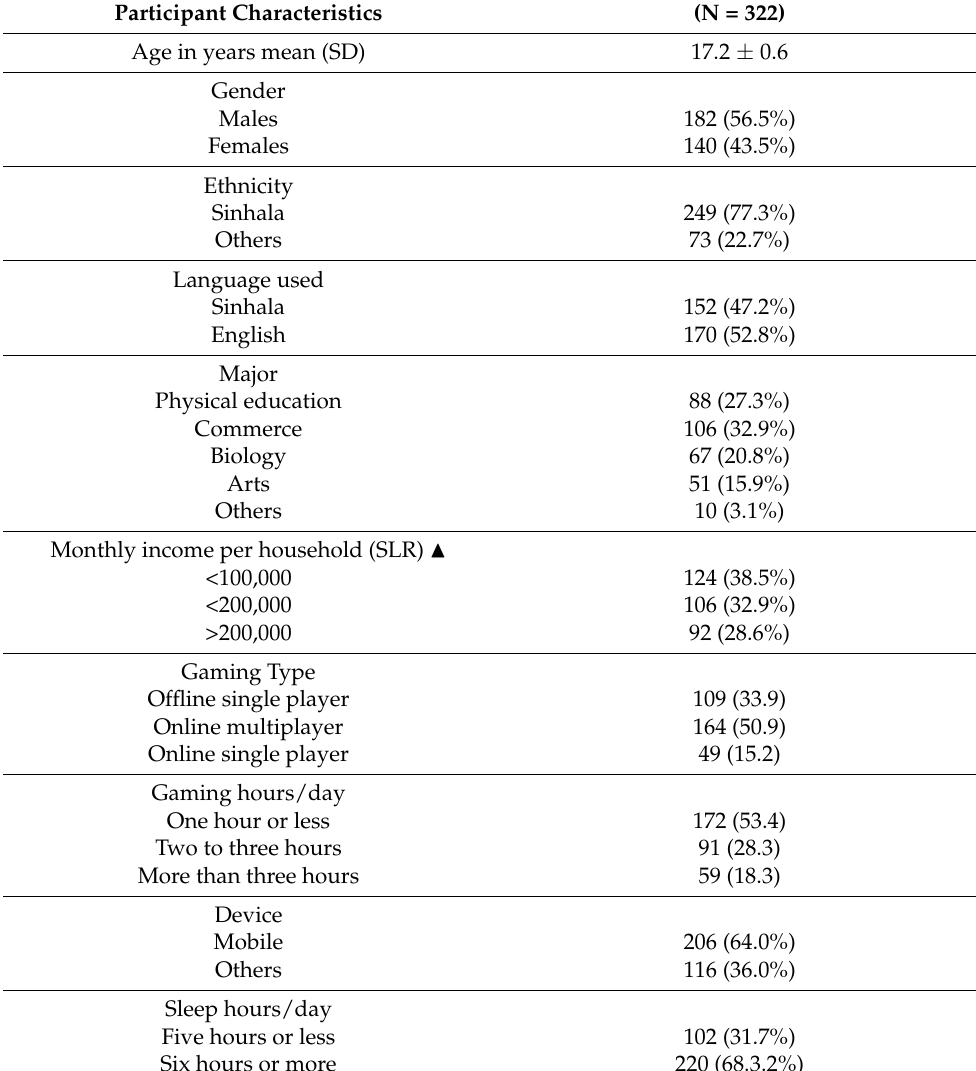
Table 1. Sociodemographic, academic, and gaming characteristics of university students from Sri